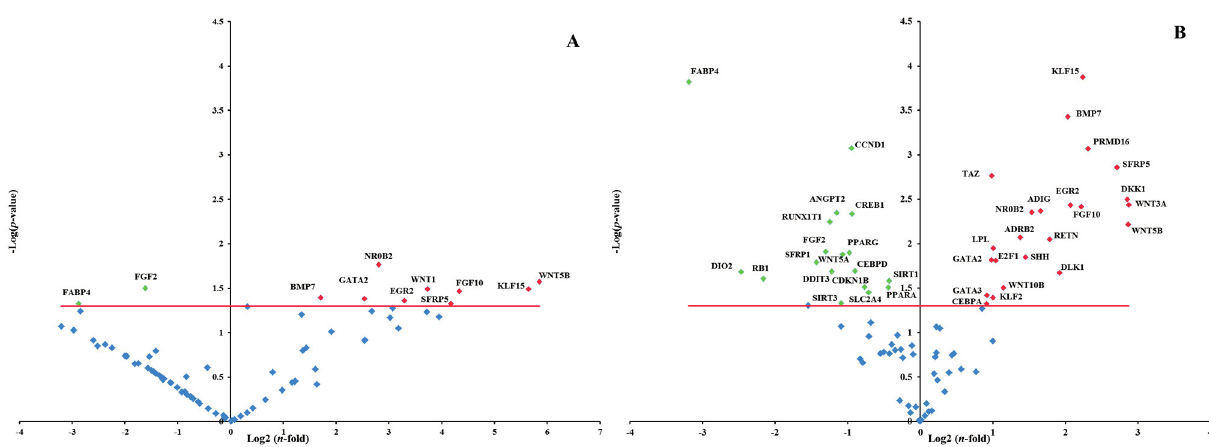
Figure 5. Volcano plot of adipogenesis PCR array. PCR array analysis of gene expression in RS and RR-treated P20 cells in comparison to P20 CTRL cells. ( A ) Gene expression of P20 RS-treated cells. ( B ) Gene expression of P20 RR-treated cells. Total RNA from three independent experiments, one per each donor, was isolated from both CTRL cells and cells treated with RR or RS extracts incubation. Cells were used at the third passage. The relative expression levels for each gene depicted as log 2 ( n -fold) are plotted against − Log( p -value). Red indicator = significantly up-regulated gene; Green indicator = significantly down-regulated gene. Red line indicates − Log( p -value), p <